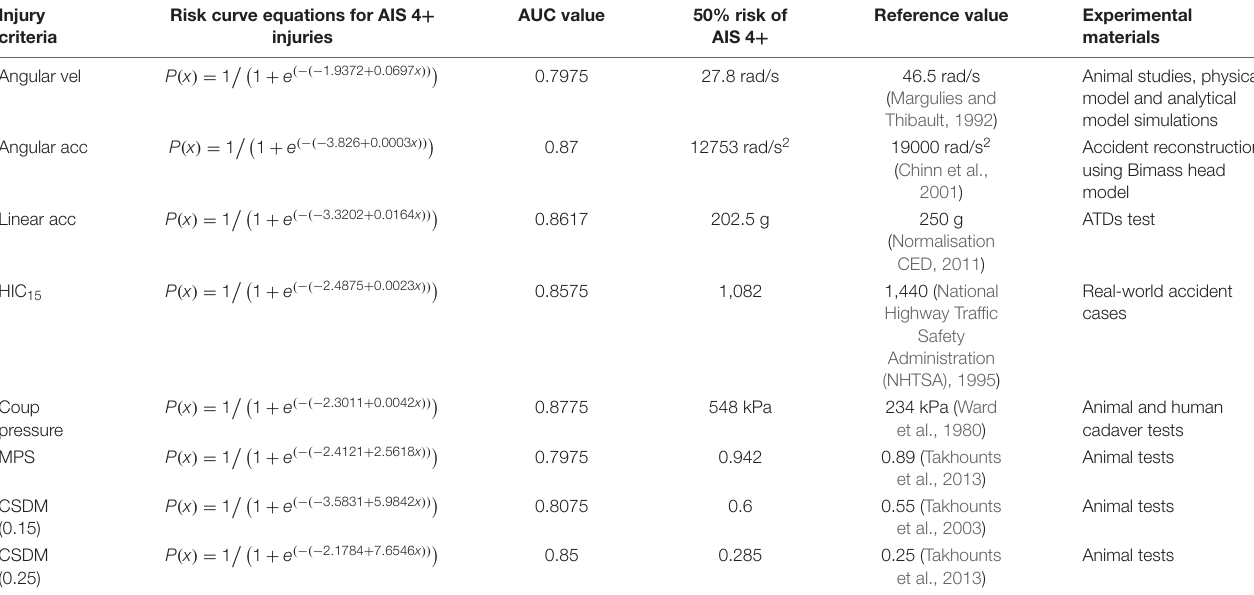
TABLE 3 | Summary of the results of head AIS 4 + injury risk